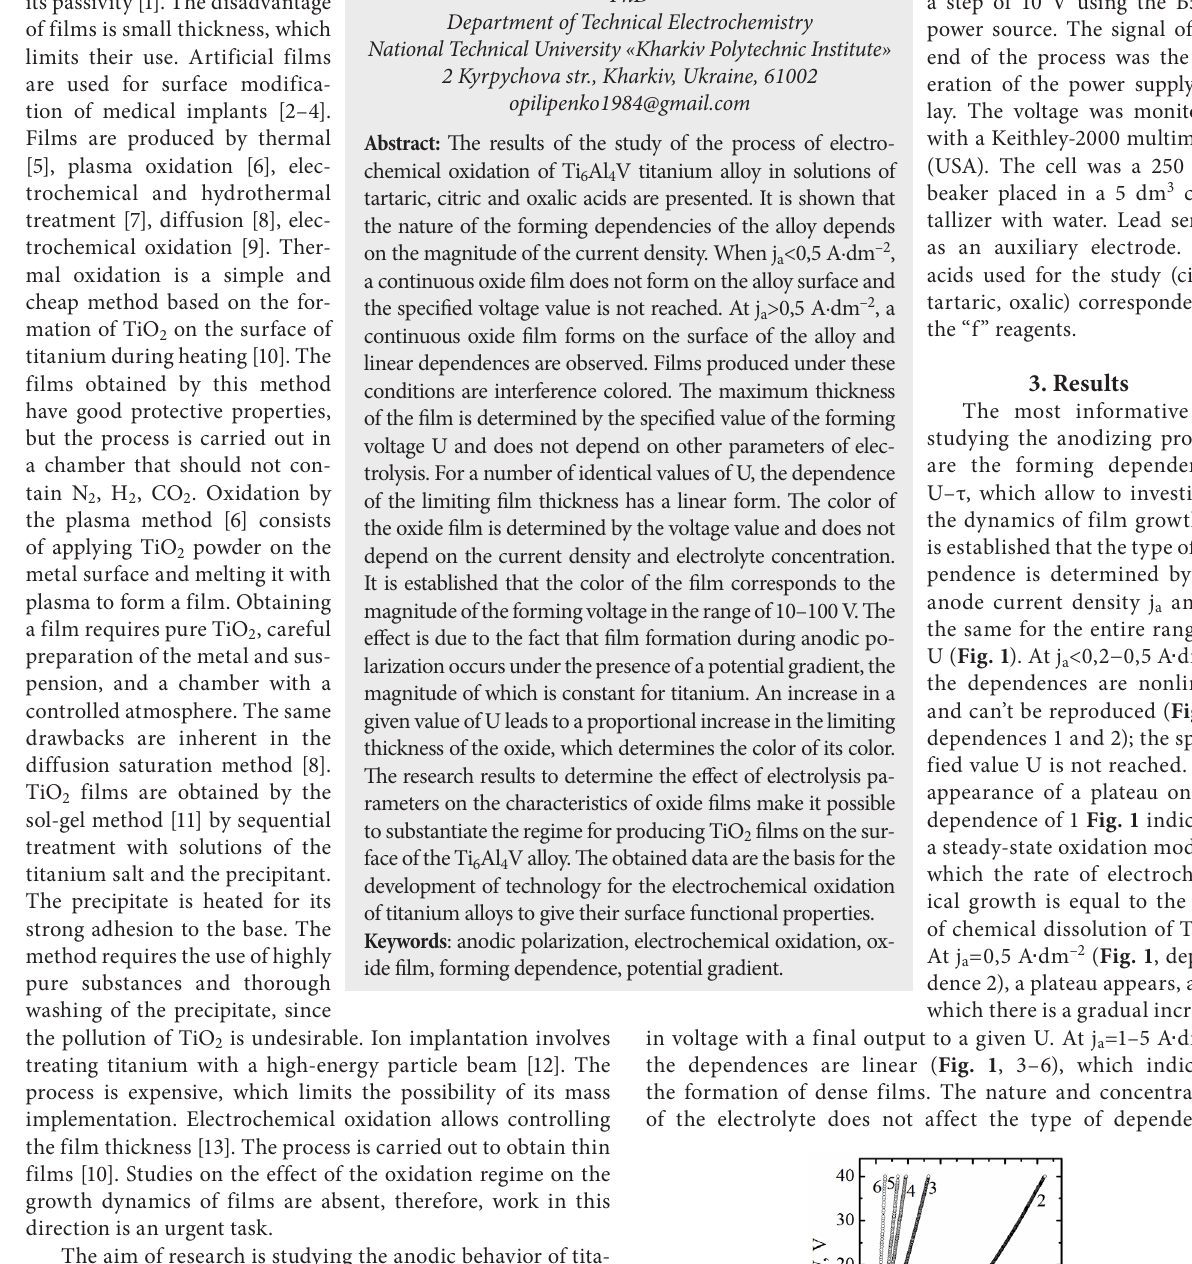
The color of the film is determined by the thickness of TiO 2 , which depends on the value of U . The correspondence between the color of the film and the voltage is given in Table